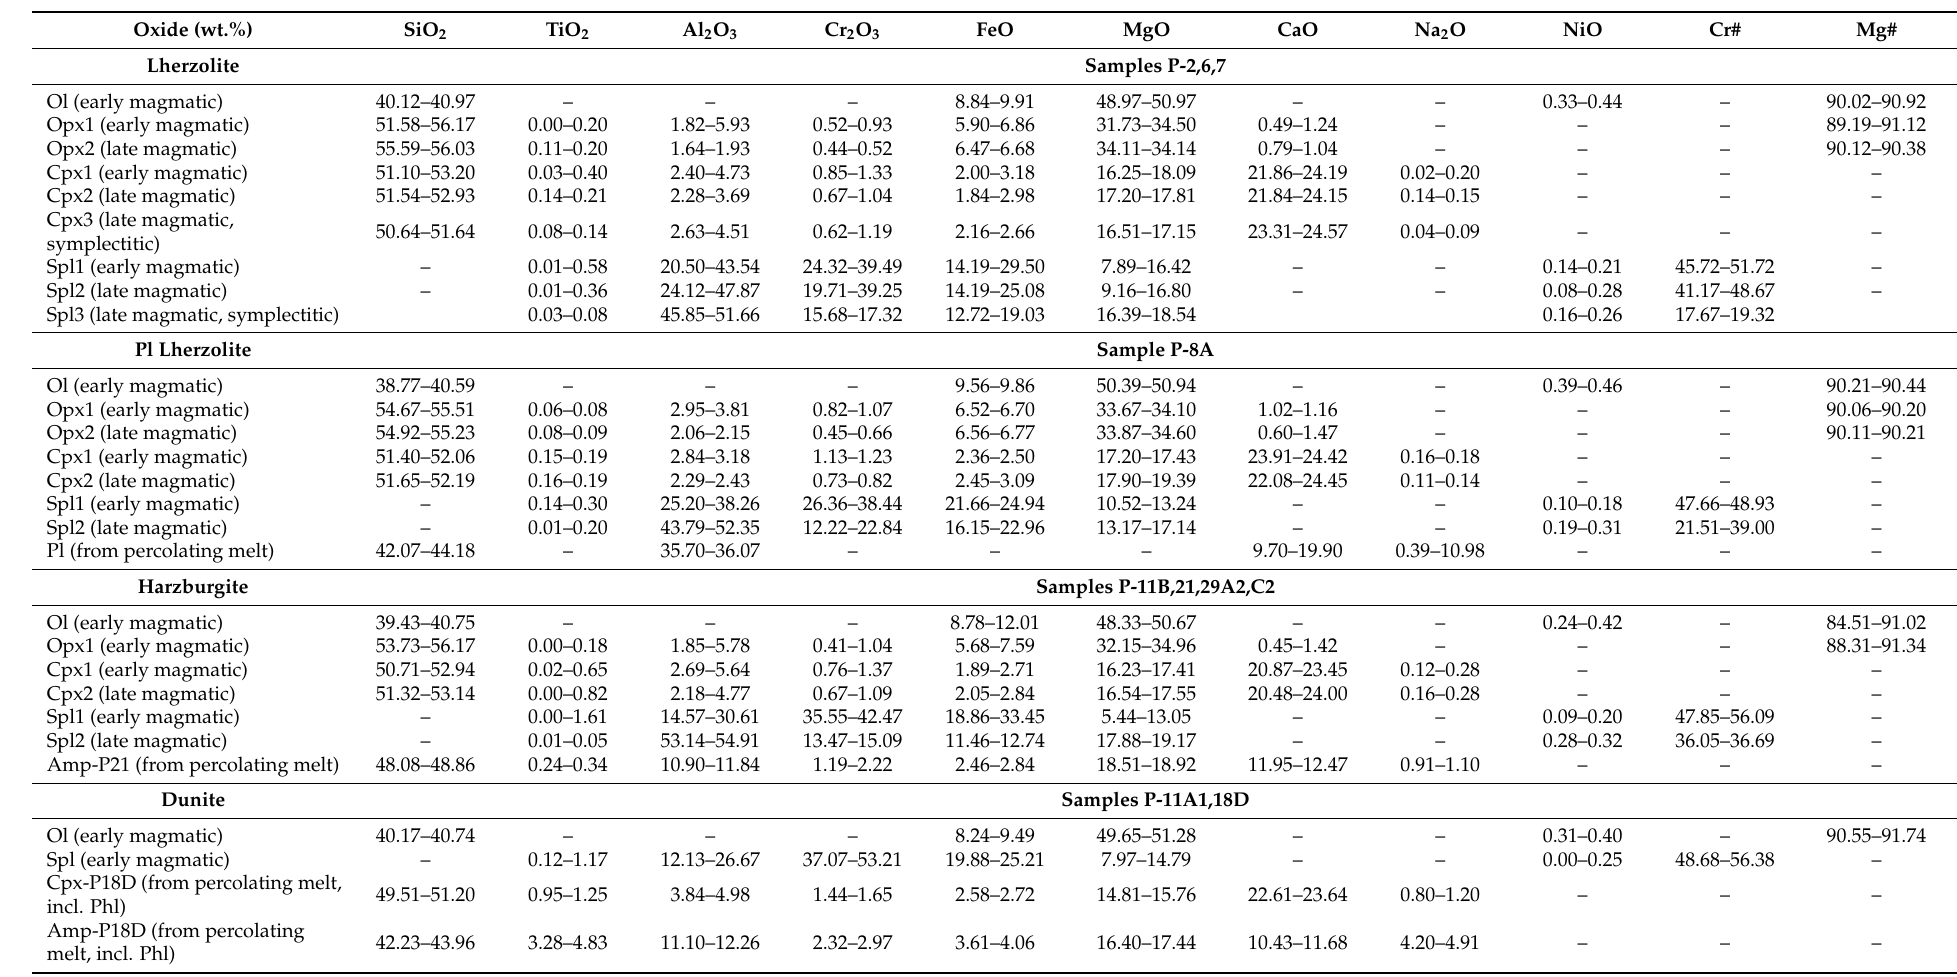
Table 2. Mineral chemistry of ultramafic